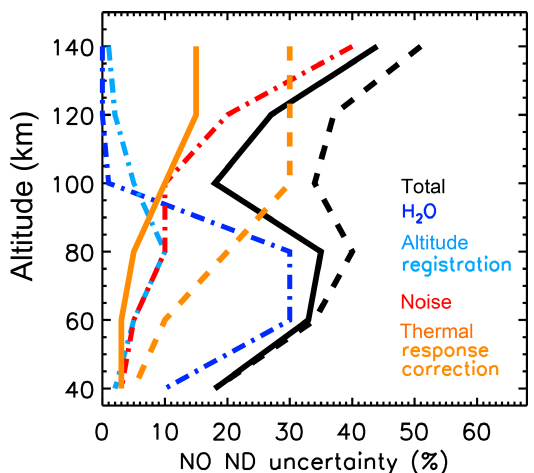
Figure 4. SOFIE NO uncertainties vs. height. Results are shown for the four largest error mechanisms (by color), and for the total (random plus systematic) uncertainty. Values are as given in Table 1. Dashed curves represent sunrise and solid curves indicate sunset results. Dotted–dashed lines apply to both sunrise and